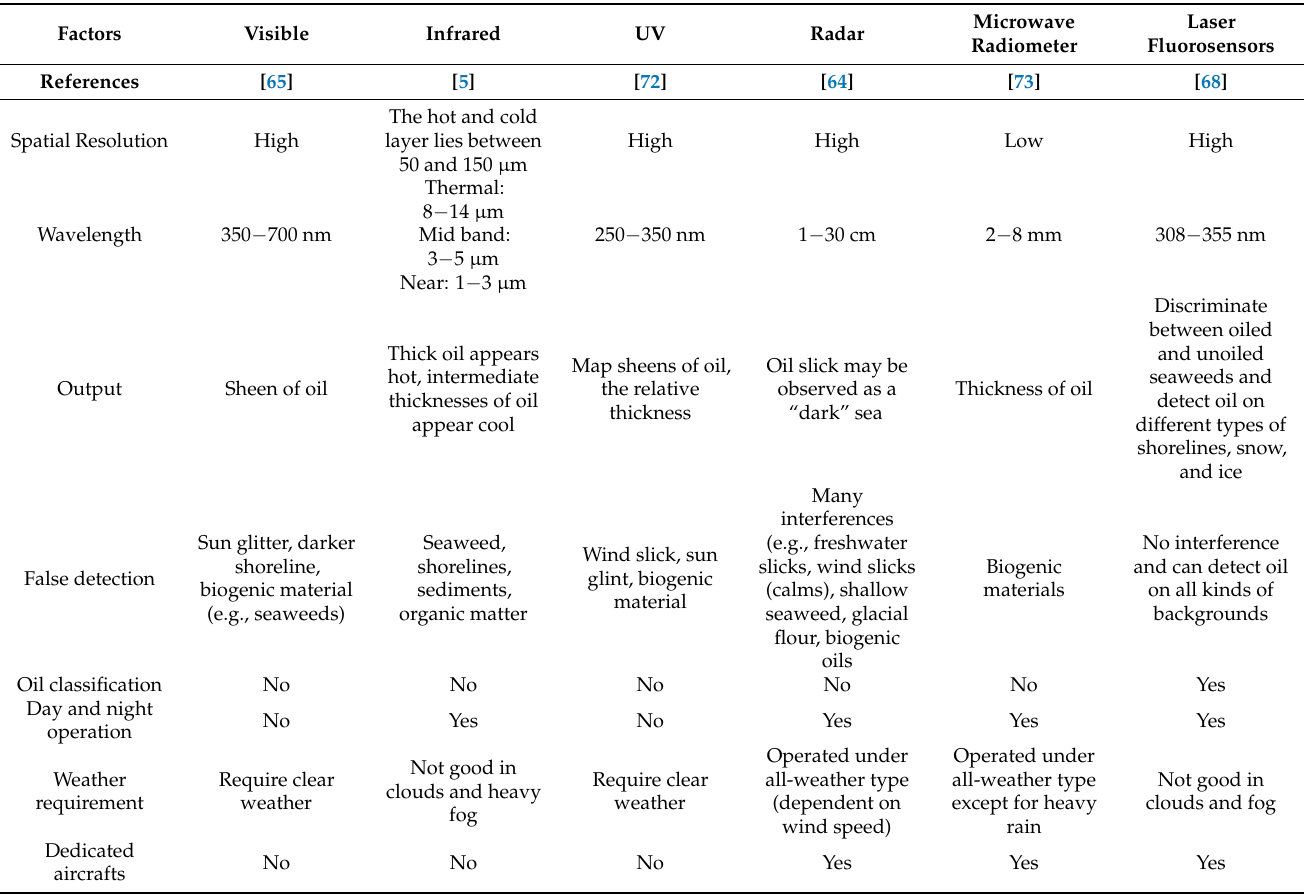
Table 2. Comparison of various remote sensors for oil spill